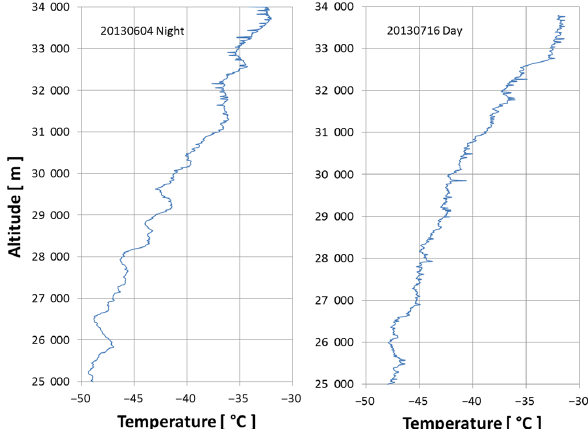
Figure 2. Stratospheric temperature profiles measured from ascend- ing balloons during nighttime (left panel) and daytime (right panel) with a Meteolabor SRS-C34 radiosonde. The nighttime profile ex- hibits negative temperature spikes above 31km, while the daytime profile shows positive spikes above 25km. Both ascent profiles are affected by the exchange of heat between the balloon gas and the external air that was in contact with the balloon skin just prior to reaching the temperature